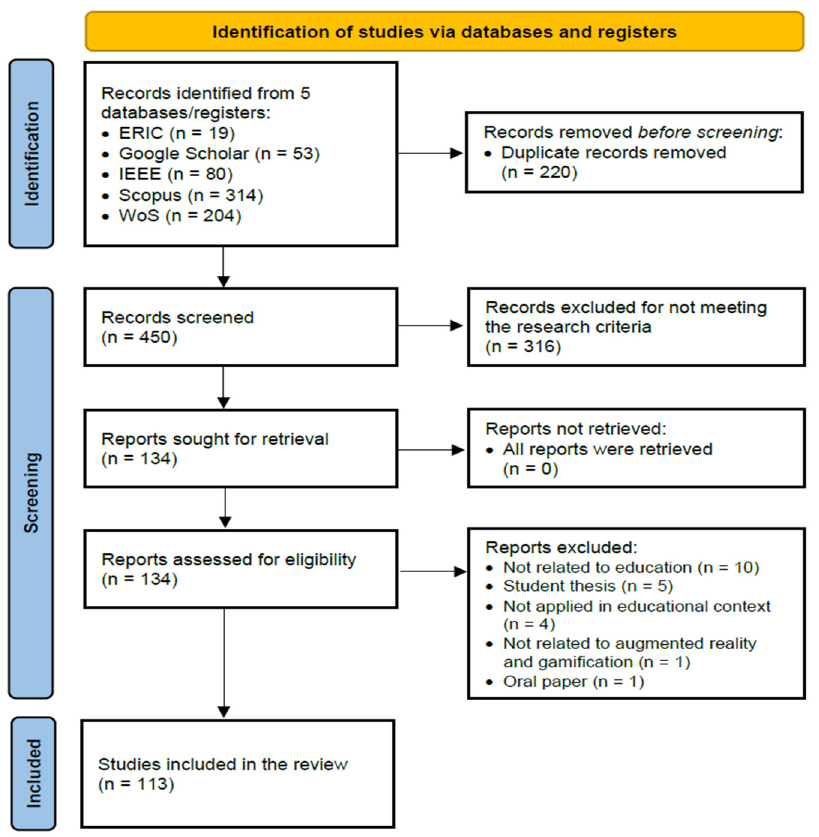
Figure 1. Prisma flow diagram.